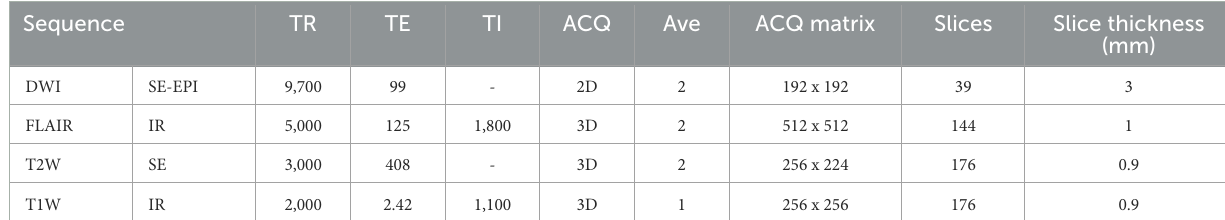
TABLE 1 MRI acquisition